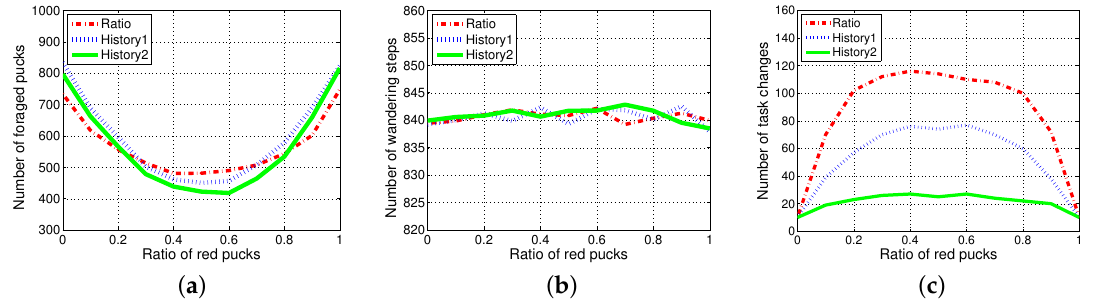
Figure 7. Performance evaluation with varying ratios of red pucks. ( a ) Number of all foraged pucks; ( b ) number of wandering steps; ( c ) number of task